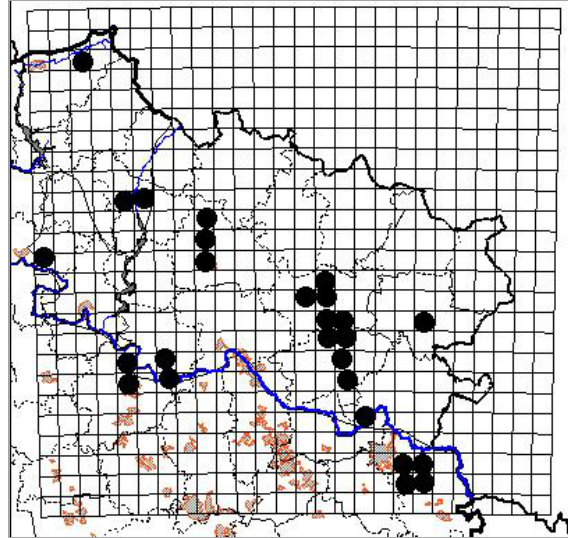
Fig. 8. The map of the distribution of Bidens frondosa L. in the Starobilsk grass-meadow steppe